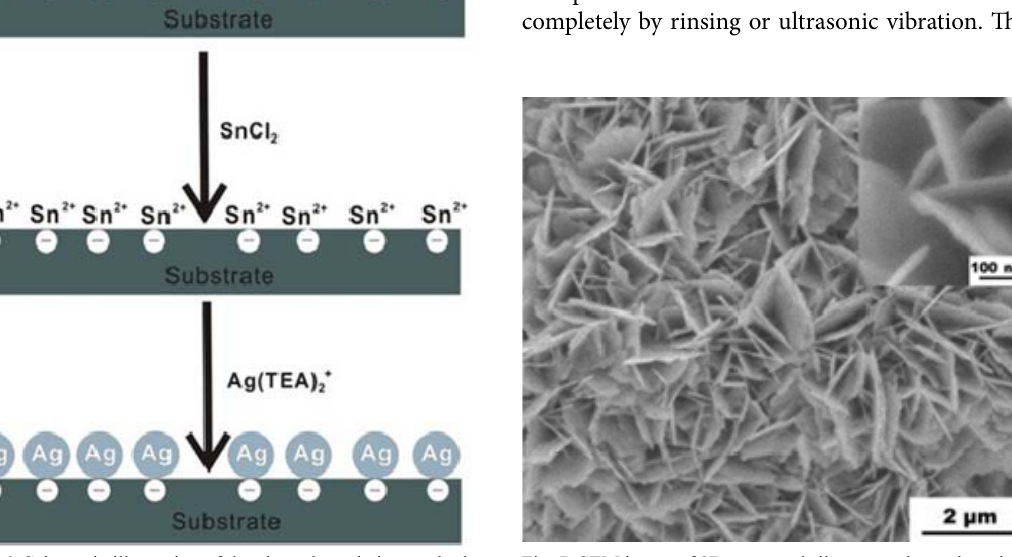
253 Nanochem Res 2(2): 248-260, Summer and Autumn 2017